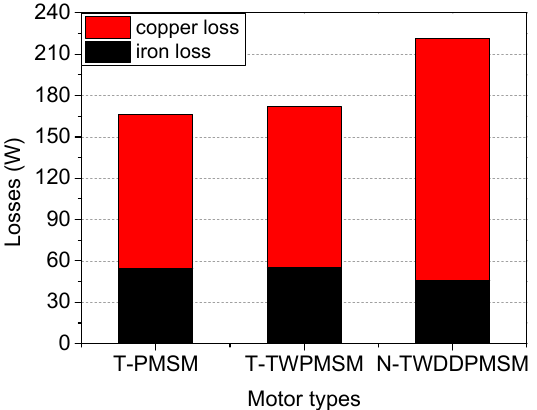
( b ) Figure 14. Waveforms of torques of three motors under rated operation: ( a ) torque waveforms; ( b ) Fourier components. C. Losses Characteristic The motor losses usually include rotor losses and stator losses, which have a large effect on the efficiency and power factor of the motor. However, the electrical conductivity of the permanent magnets